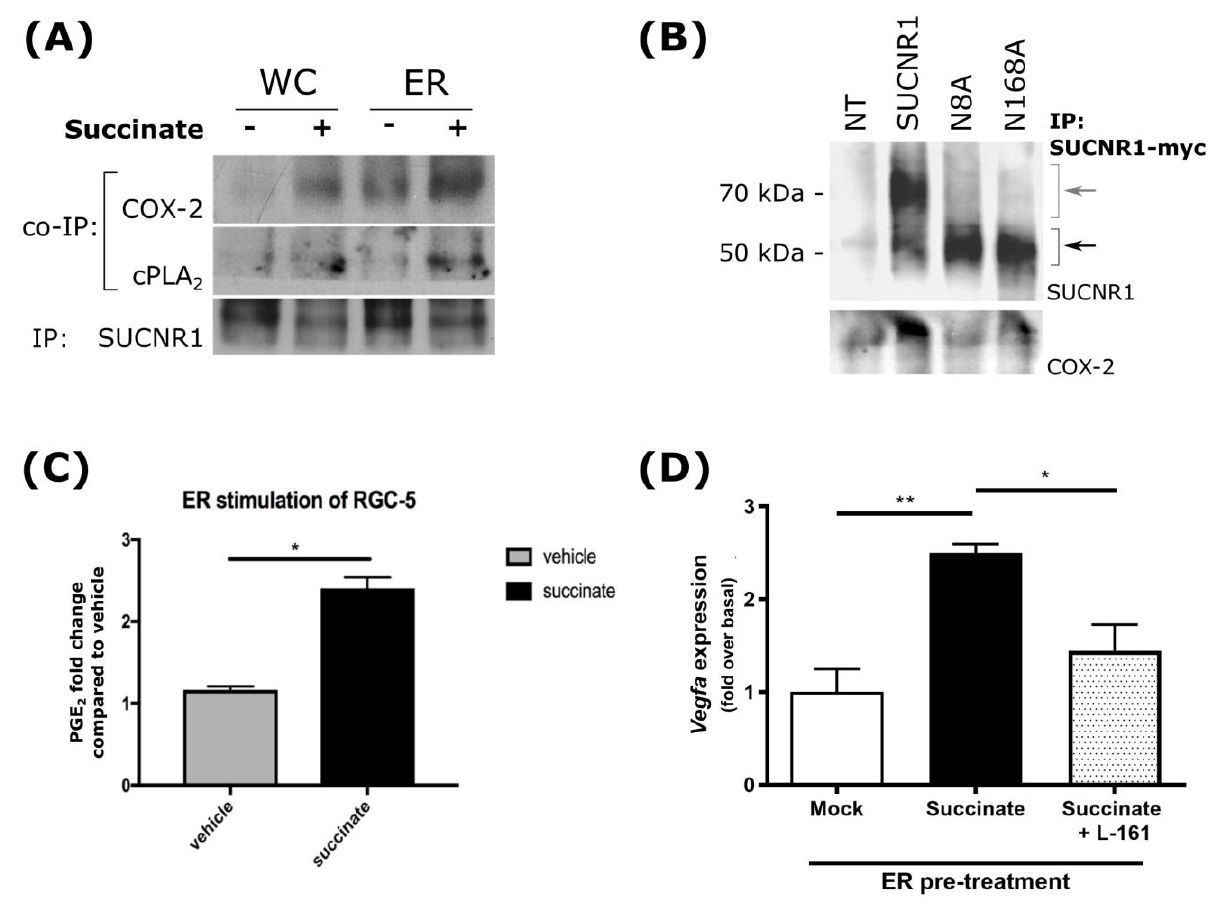
Figure 5. ER − localized SUCNR1 interacts with the PGE synthesis pathway. ( A ) Co-immunoprecipitation of cPLA 2 or COX-2 with the endogenous SUCNR1 in whole-cell or ER fraction from RGC-5 treated (+) or not ( − ) with 100 µ M succinate. Immunoprecipitation was performed with an antibody specific to SUCNR1, and is shown as IP loading control. COX-2 and cPLA 2 coIP signals increased upon succinate stimulation. ( B ) Co-immunoprecipitation of COX-2 with SUCNR1-myc expressed in HEK 293T cells. IP was conducted with an anti-myc antibody, and the presence of SUCNR1 and COX-2 in precipitates was assessed using the corresponding antibodies. Signal from wild-type and mutant SUCNR1 are indicated by grey and black arrows, respectively. COX-2 signal was strongest in lysates from cells expressing the fully glycosylated, wild-type SUCNR1. ( C ) Succinate stimulation of isolated ER from RGC-5 led to the production of PGE 2 . N = 6 * p < 0.05. ( D ) RGC-5 ER fractions were treated or not with 100 µ M succinate for 30 min at 37 ◦ C. Subsequently, isolated nuclei from RGC-5 cells were incubated for 30 min at 37 ◦ C with the corresponding ER fractions in the presence or absence of EP 4 antagonist L-161,982, after which Vegfa expression was quantified by RT-qPCR. N = 4 (* p < 0.05, ** p < 0.01). ( C , D ) * and ** p < 0.05 and p < 0.01, respectively, vs. comparative values.